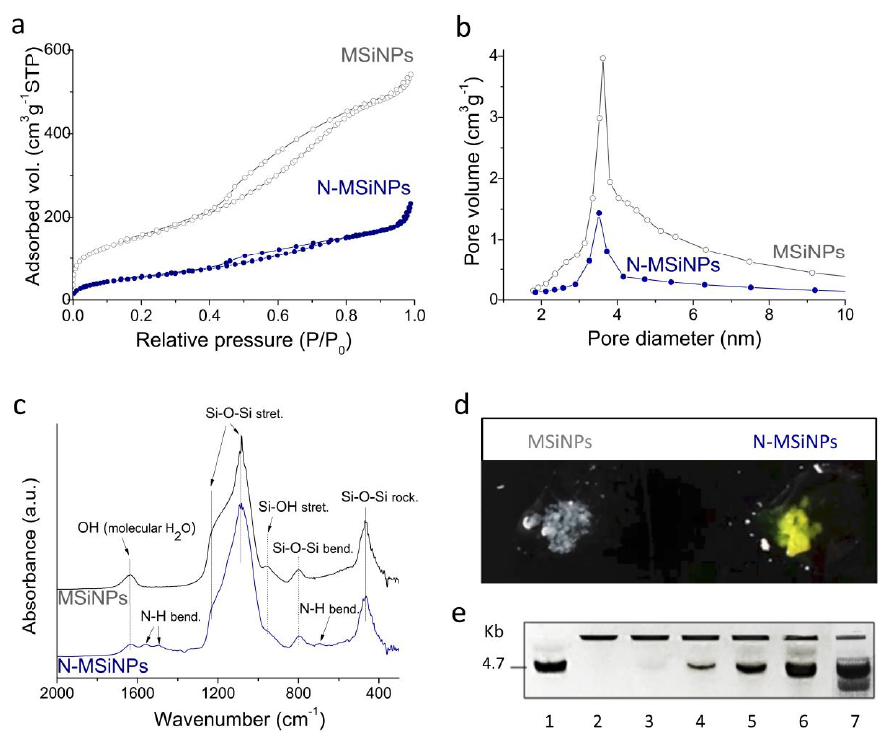
Figure 2. Physico-chemical characterization of the studied nanoparticle materials. ( a ) N 2 adsorption– desorption isotherms. ( b ) Adsorption branch BJH pore size distributions. ( c ) FT-IR analysis. ( d ) Salicylaldehyde reaction analysis. ( e ) Electrophoresis gel image showing the retardation effect of essayed DNA plasmid, pEGFP-N1, after functionalized nanoparticles, N-MSiNPs, complexa- tion using different pEGFP-N1: N-MSiNP ( µ g: µ g) ratios: (1) 1:0 (DNA control sample), (2) 1:300, (3) 1:150, (4) 1:75, (5) 1:37.5, and (6) 1:18; and a second control sample using the